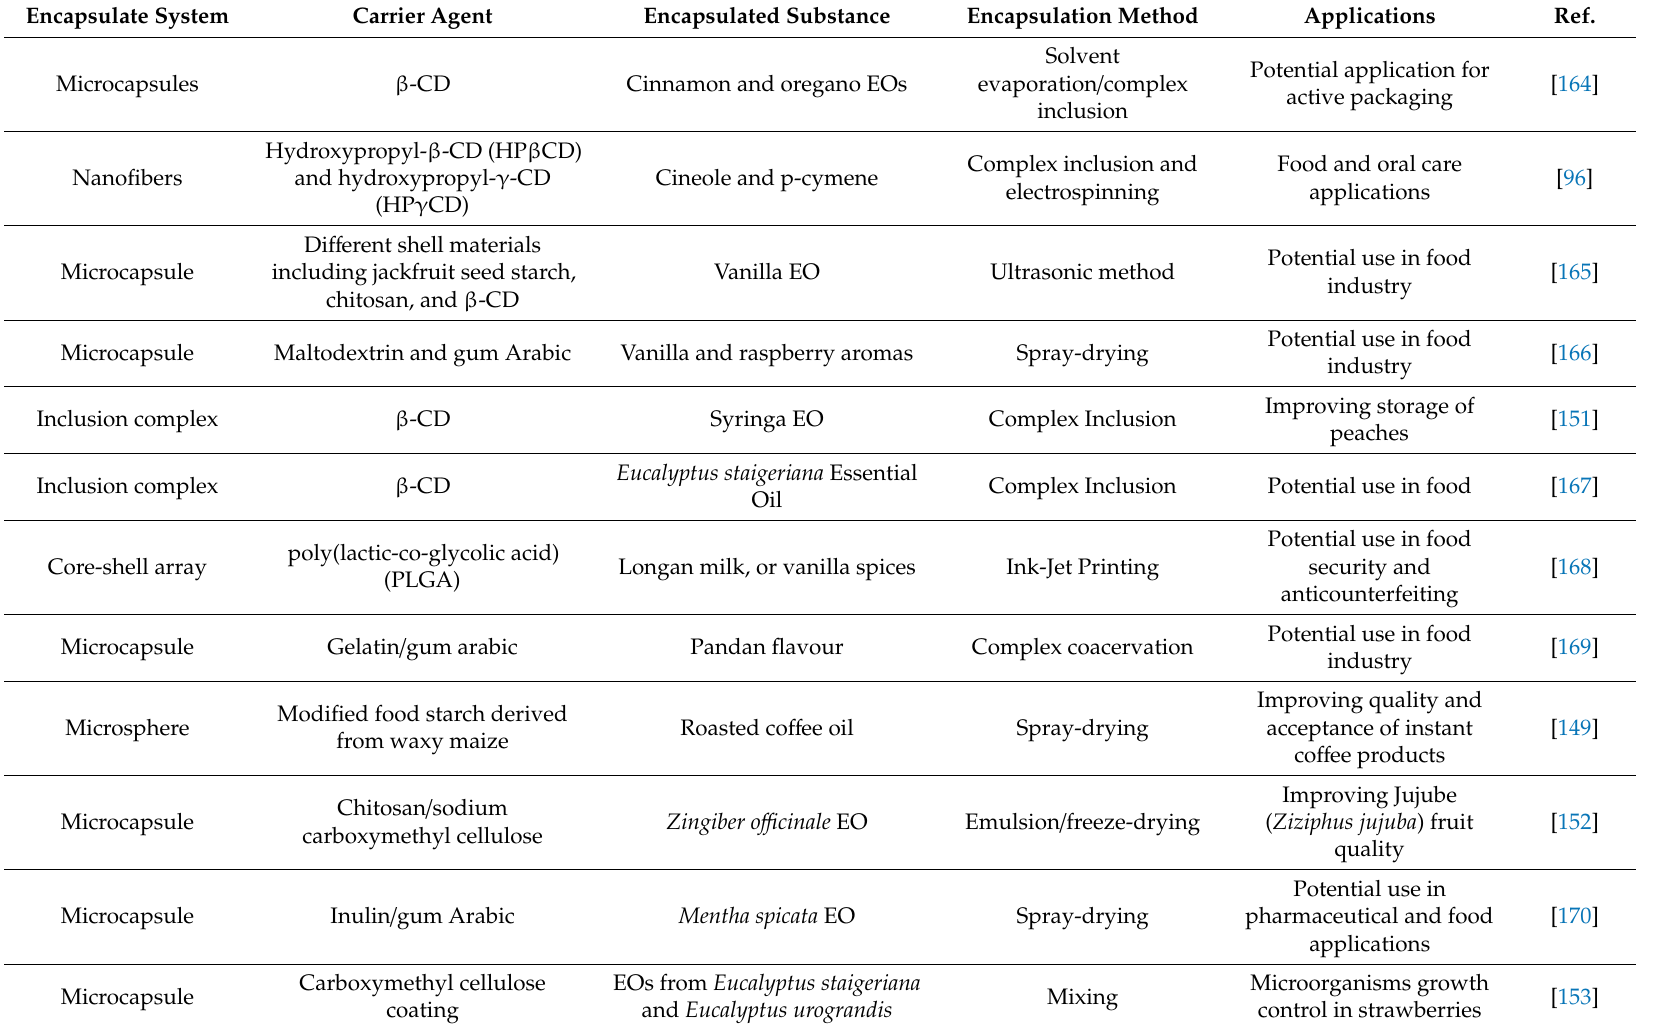
Table 3. Recent studies reporting the micro / nanoencapsulation of fragrances and flavours for food